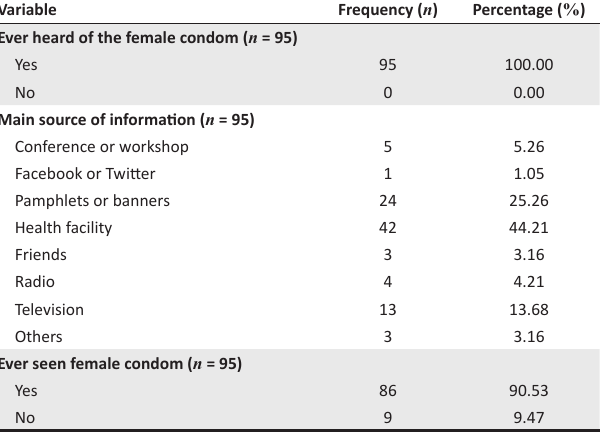
TABLE 2: Knowledge and source of information about female condom.